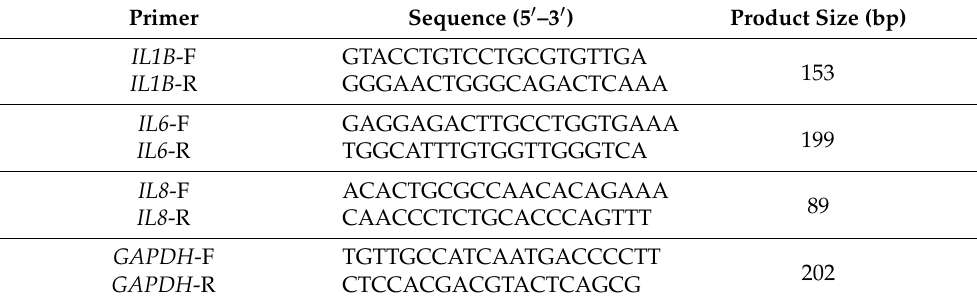
Table 2. Sequences of primers used in this